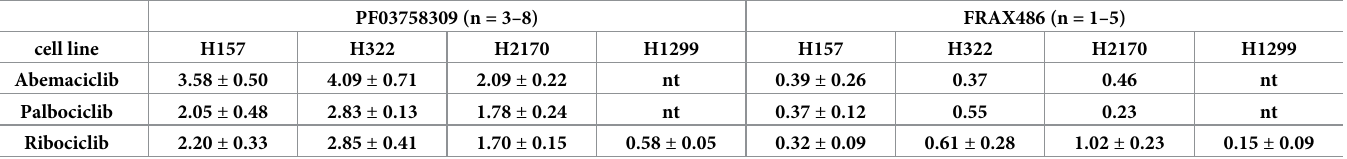
Table 1. Synergy values.